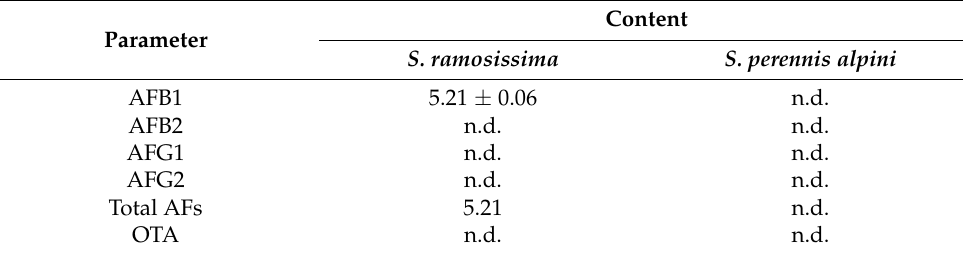
Content S. ramosissima